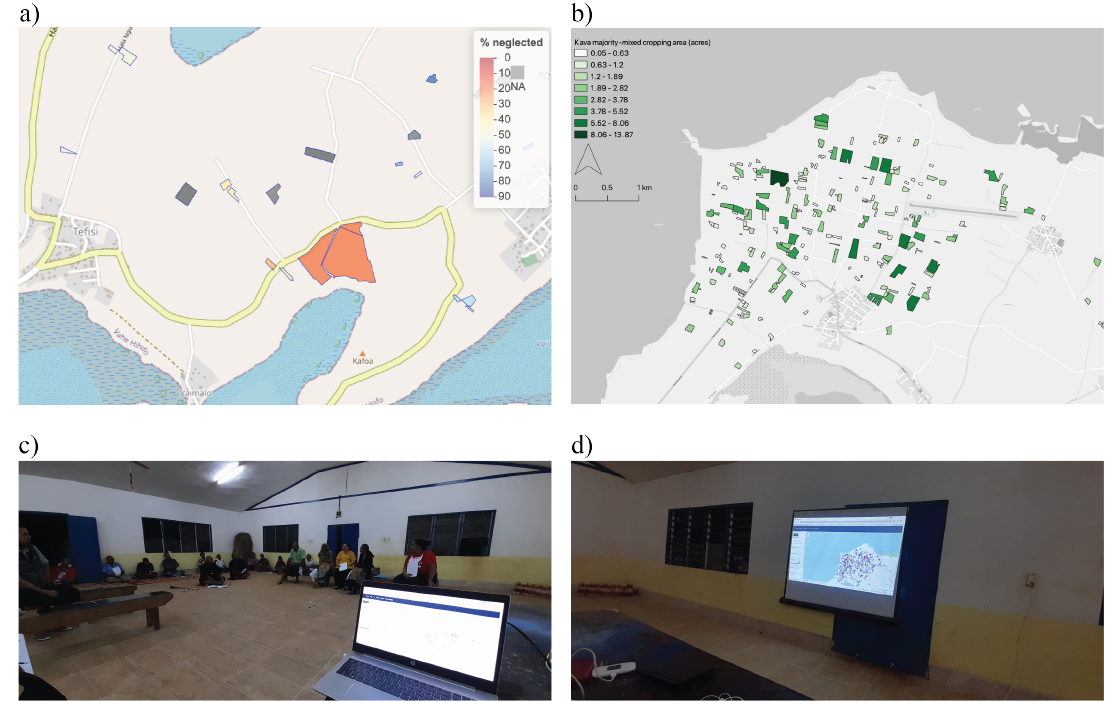
Figure 5. Web map of % of vanilla plantations in neglected condition (OpenStreetMap basemap) (a), map of the area of fields with mixed kava cropping systems (b), and photos from community feedback meetings presenting crop survey results to farmers